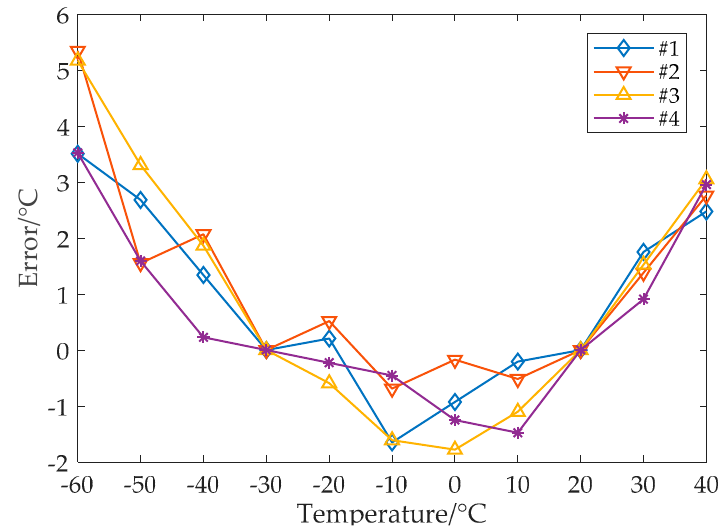
Figure 10. Temperature measurement error for the range of − 60 to +40 °C with the conventional linear calibration.